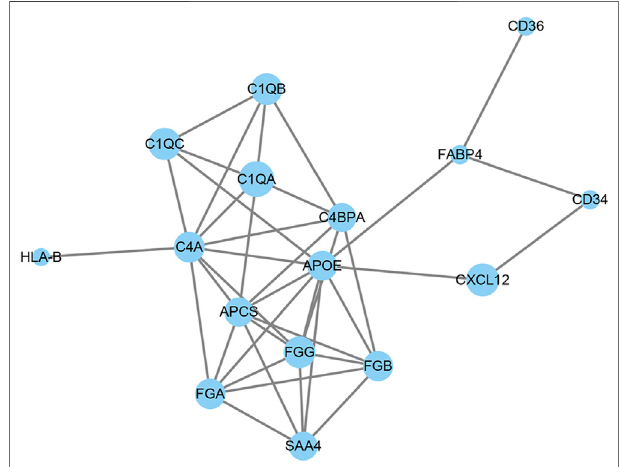
FIGURE 5 | Protein – protein interaction (PPI) network of differential abundant